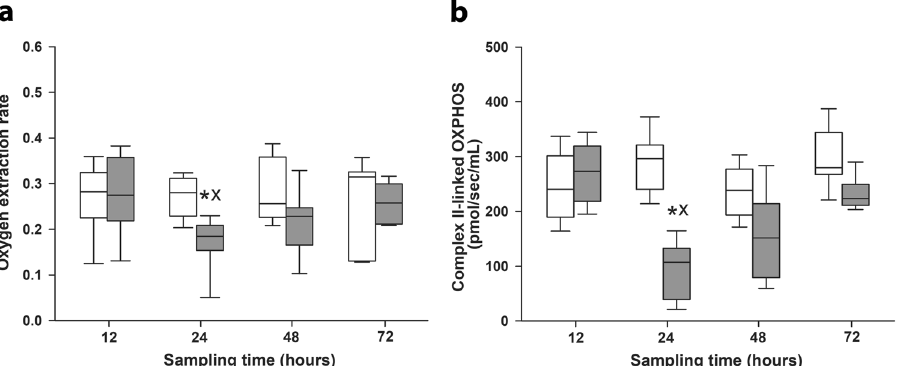
Figure 3. Oxygen extraction rate (a) and mitochondrial respiration (b) in sham-operated animals (n = 12–13, white boxes) and in the different sepsis groups representing different stages of sepsis (grey boxes). The number of animals used in various sepsis groups is indicated in Table 1. Plots demonstrate the median (horizontal line in the box) and the 25th (lower whisker) and 75th (upper whisker) percentiles. Comparison between groups was conducted with the Kruskal–Wallis test followed by Dunn’s post-hoc test. X P < 0.05 vs sham-operated groups; * P < 0.05 vs 12 h sepsis (between sepsis groups); # P < 0.05 vs 24 h sepsis (between sepsis